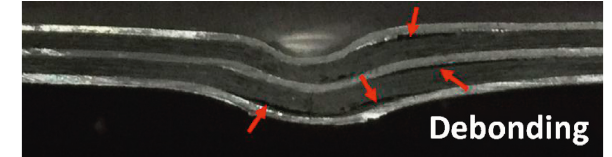
Figure 8: Debonding of the thick BFML plate under low energy